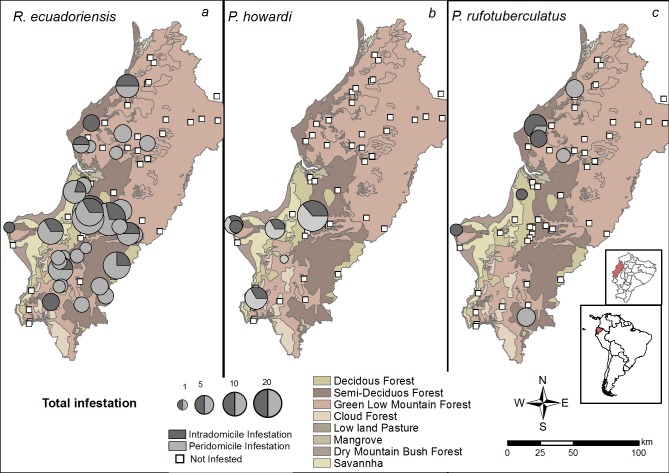
Triatomine infestation in Manabí province, central coast of Ecuador encompassing five ecological regions.Location of each community surveyed is marked. The size of the symbol corresponds to the % of houses infested with triatomines in each community with each of the three triatomine species found (A = R. ecuadoriensis, B = P. howardi and C = P. rufotuberculatus). Dark grey and light grey represent intradomicicle and peridomicile infestation, respectively and white squares represent non-infested communities. Inserts indicate the location of Manabí province within Ecuador and of Ecuador in South America.